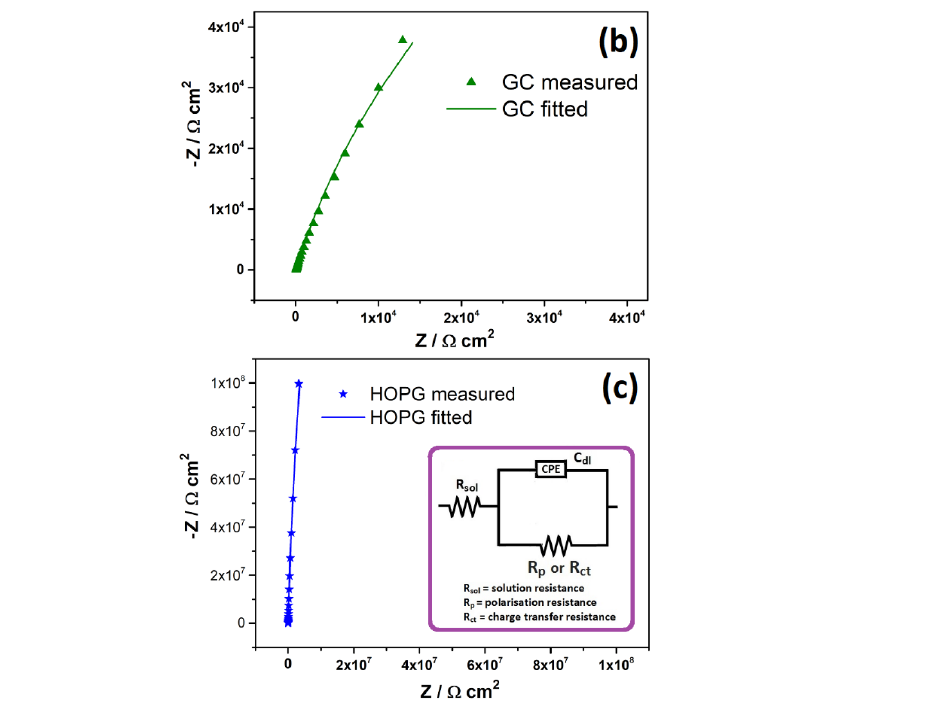
Figure 4. Nyquist plots of CFRP ( a ), glassy carbon ( b ), HOPG ( c ) in 50 mM NaCl adjusted to pH 7 after 1-h immersion at OCP (inset in c is the equivalent circuit used to fit the spectra). The impedance spectra were fitted using the one-time constant equivalent circuit (in-